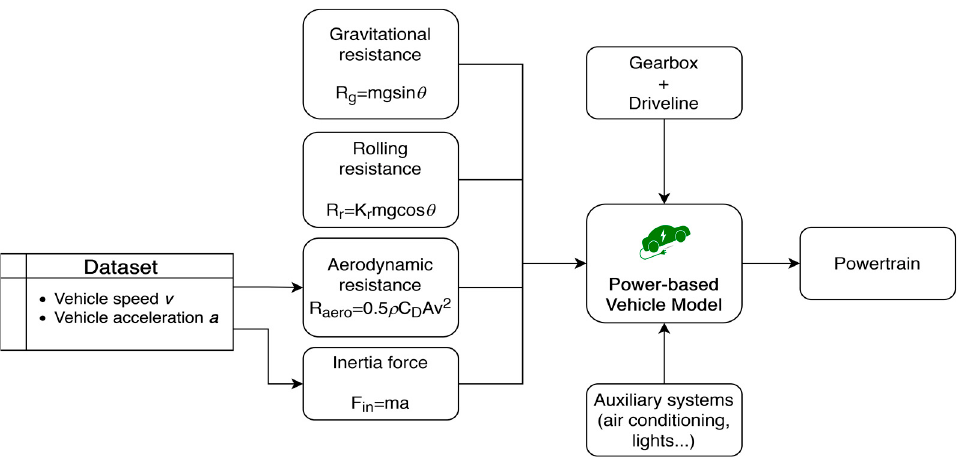
Figure 4. PVM and BVM descriptions through the block